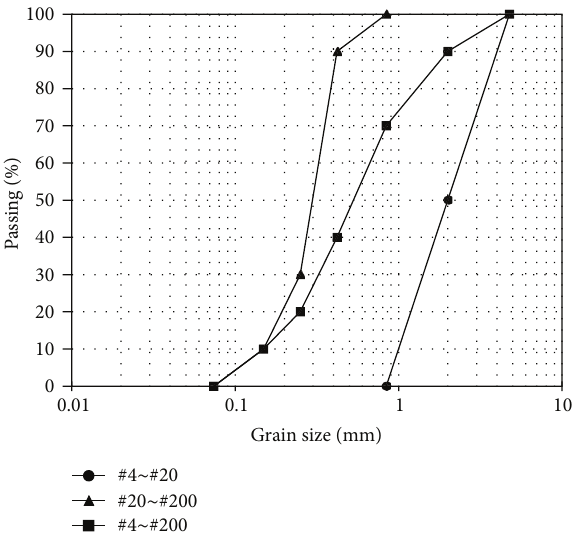
Figure 2: Grain size distributions of crumb